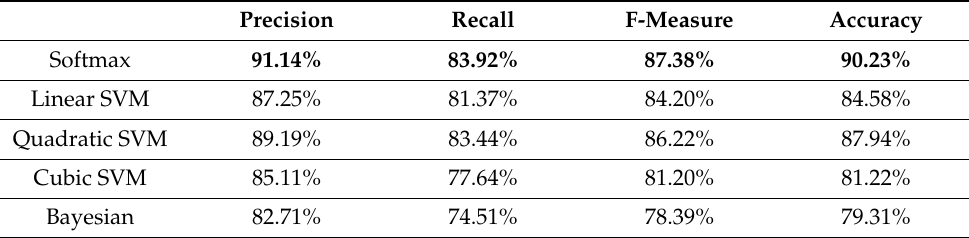
Table 4. Classification performance using contrast-enhanced dataset.